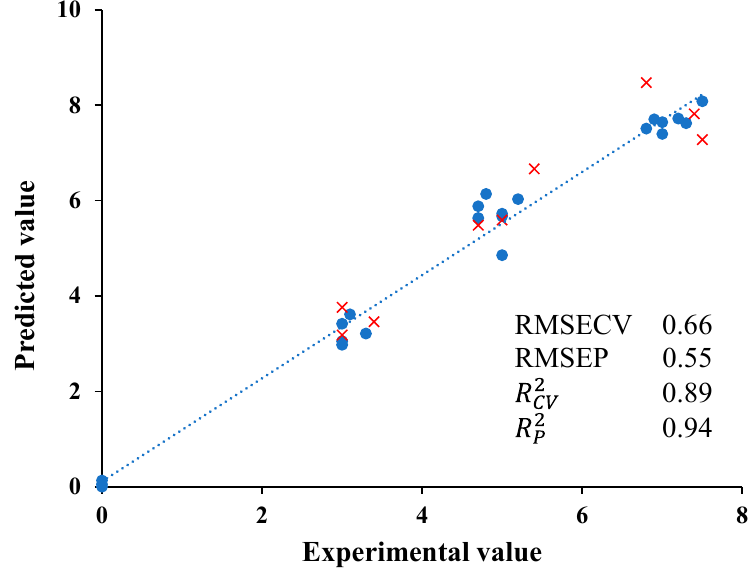
Figure 4. Experimental values against PLS cross-validation predictions ( • ) and validation set predictions ( × ) for burned aroma defect perceived by panelists.